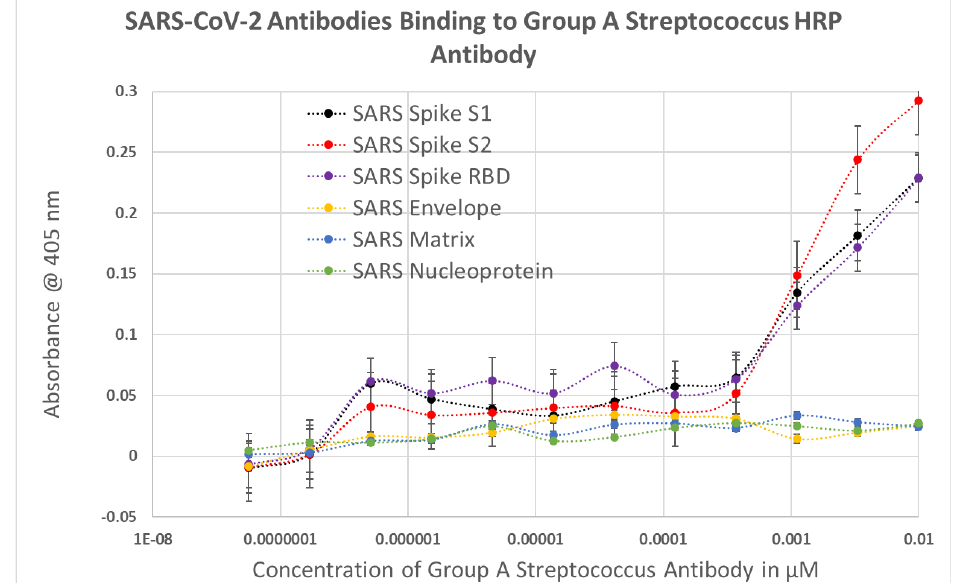
Figure 12. Results of DA-ELISA experiments testing for SARS-CoV-2 antibodies binding to Group A Streptococcus antibodies. Because both the virus and bacterial antibodies are polyclonal, multiple sets of complementary interactions are possible. Thus, while there is very clear evidence of binding between the Streptococcal antibodies and all three antibodies against SARS-CoV-2 spike region proteins at high concentrations of antibody, there also appears to be higher affinity binding at much lower concentrations of antibody (to the left). Only the high-concentration binding has been incorporated into Figure 11. S1, S2, RBD, Envelope, Matrix and Nucleocapsid are proteins of SARS-CoV-2.